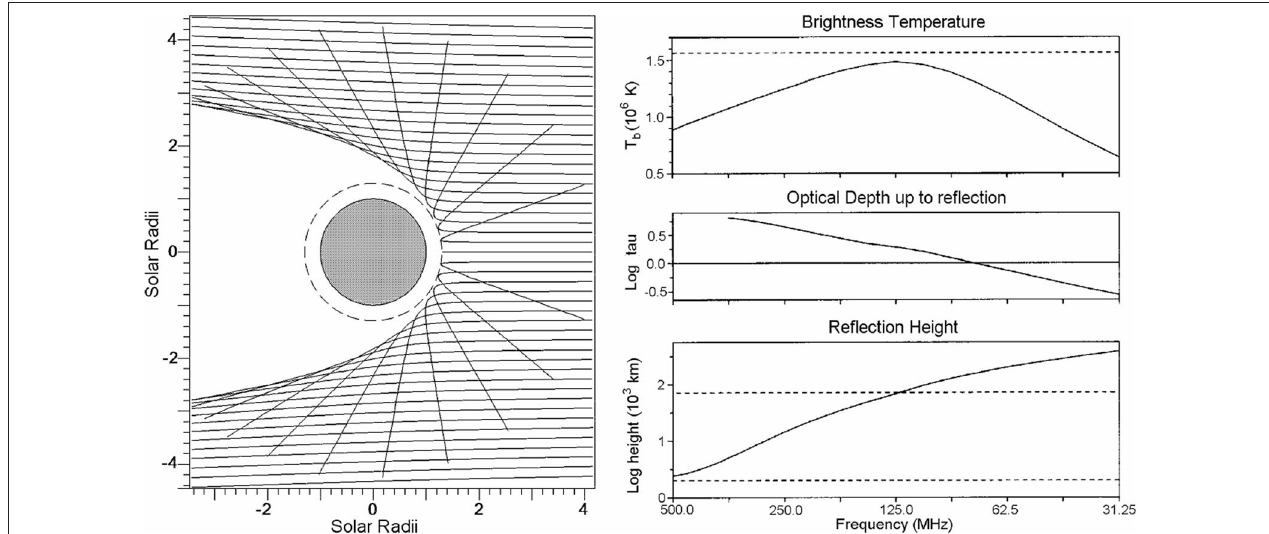
FIGURE 4 | (Left) Ray paths at metric wavelengths, showing the effects of refraction and total reflection; figure prepared by the author. (Right) The height of reflection, the optical depth up to the reflection point and the brightness temperature as a function of frequency for the center of the solar disk. The ray tracing computations were performed for a Saito equatorial density model, with a coronal temperature of 1.52 10 6 K and a constant conductive flux Transition Region with F c 10 5 ergcm − 2 s − 1 . Reprinted from Advances in Space Reseach , Vol 14, Alissandrakis, Radio observations of the quiet solar corona, 81–91 (1994), with permission = from Elsevier.